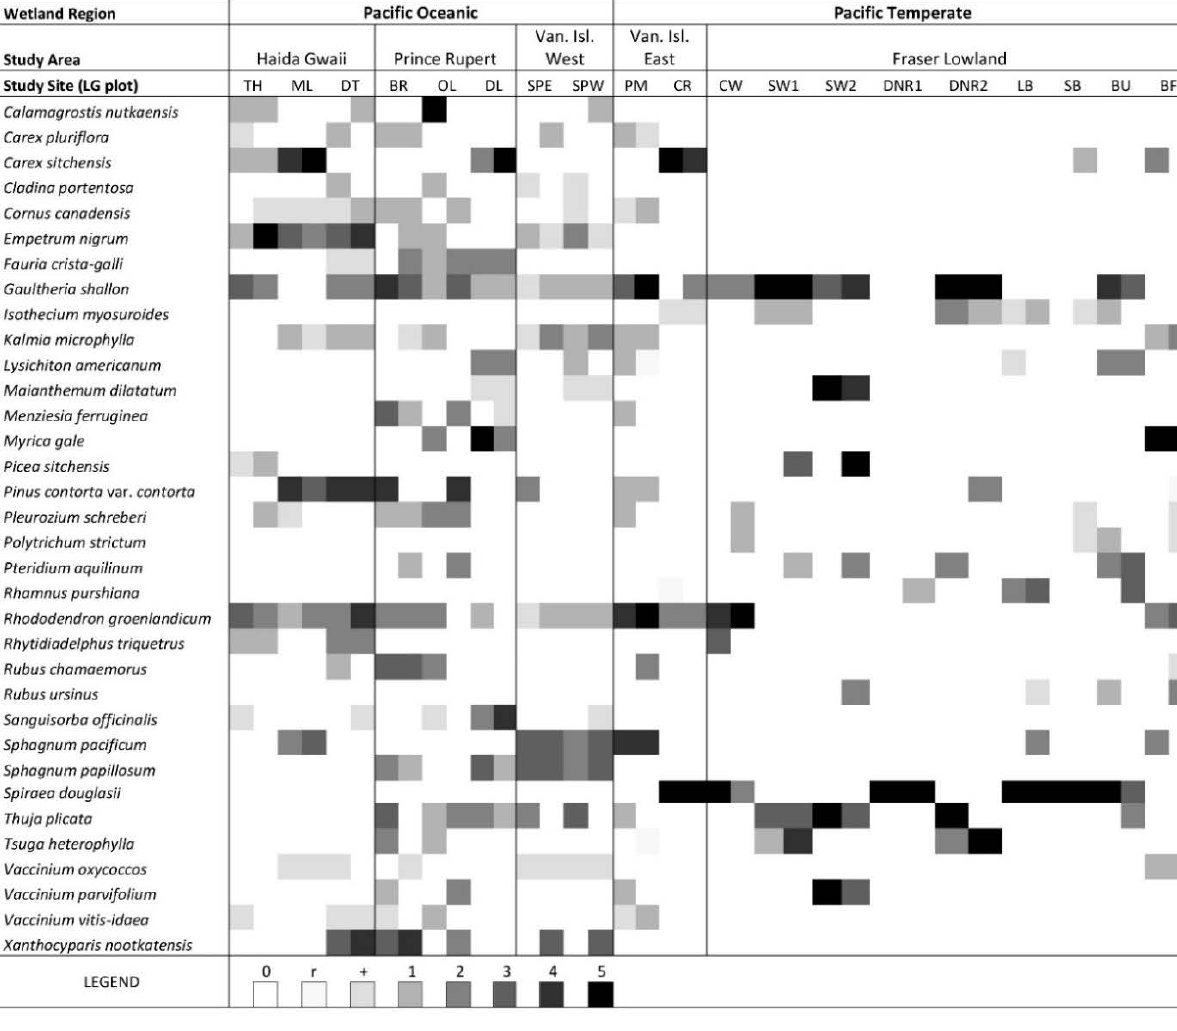
Figure 4. Species observed in at least three LG plots with coverage ≥ 1 on the Braun-Blanquet scale in at least one plot. The squares are in pairs: the first for Transect 1, the second for Transect 2. Cover codes: Cover codes: “0” = absent, “r” = solitary with small cover, “+” = few with small cover, “1” = numerous but < 5 % cover, “2” = 5–25 % cover, “3” = 25–50 %, “4” = 50–75 %, “5” = ≥ 75 % (Mueller-Dombois & Ellenberg 1974). See Figure 1 for site codes. The LG plots are ordered by wetland region and study